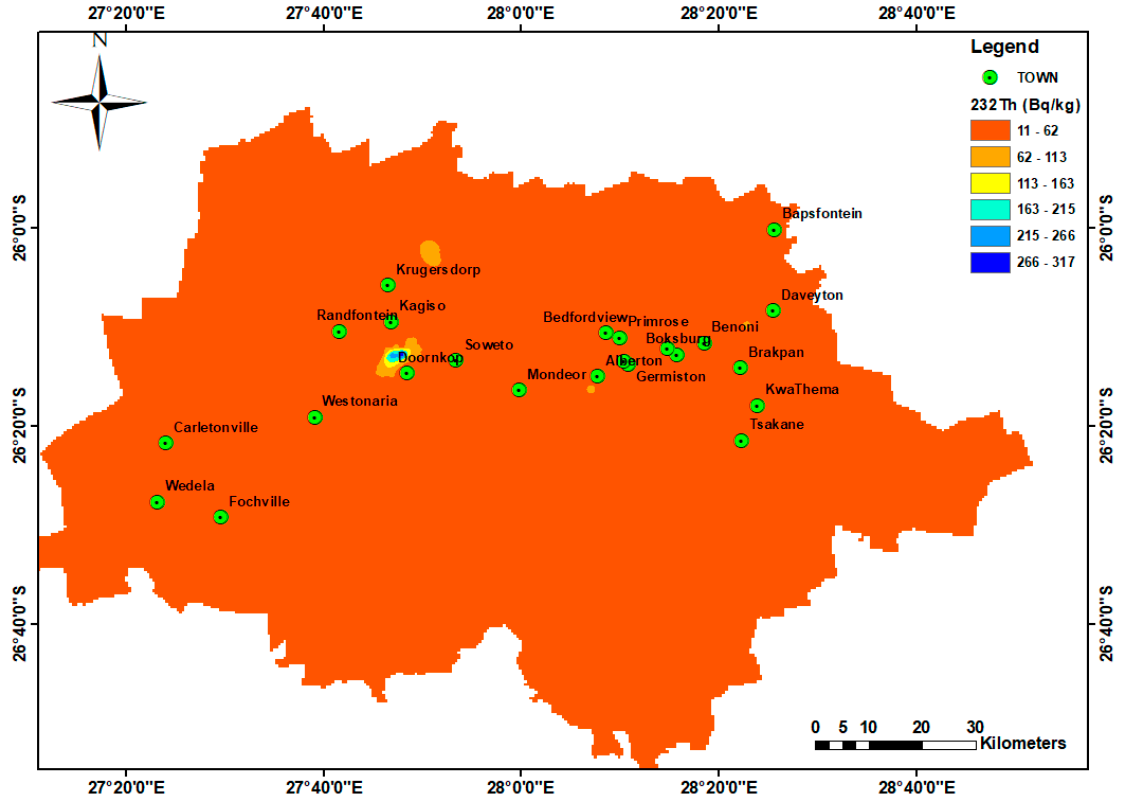
Figure 9. Spatial activity distribution map of 232 Th (Bq/kg).